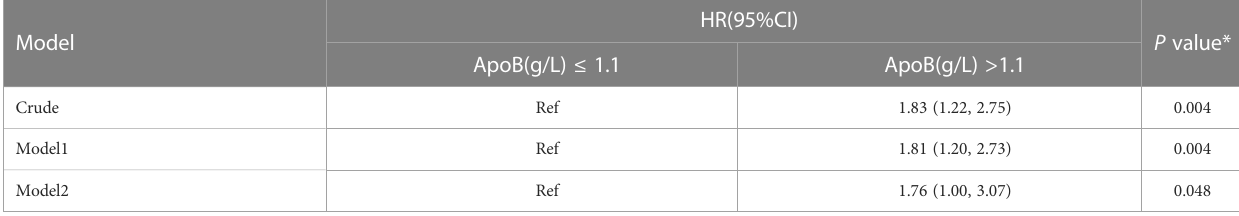
TABLE 5 Association between the baseline ApoB and incident of CKD in the 4 years longitudinal cohort.